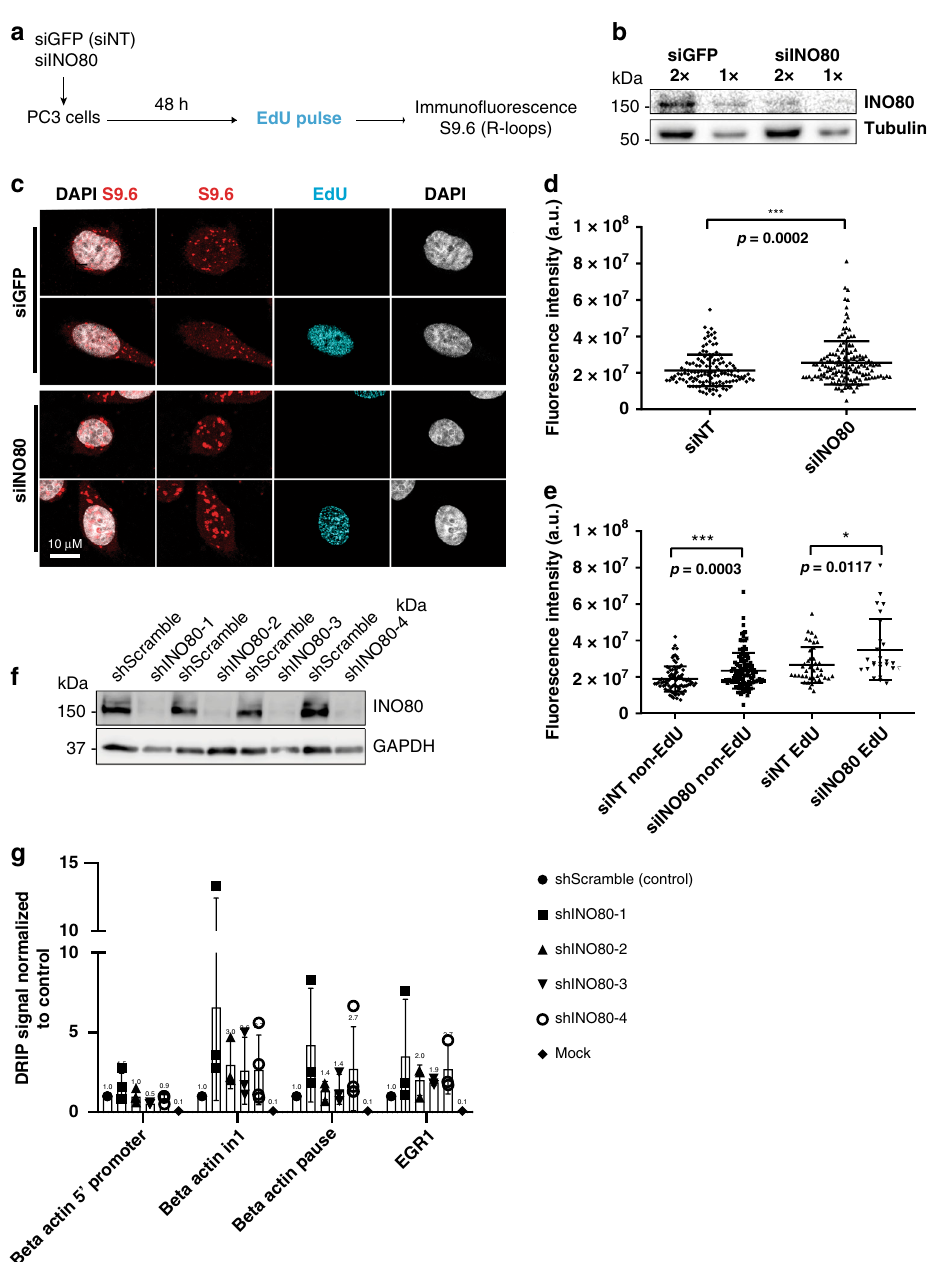
Fig. 4 R-loops accumulate in INO80-depleted cells. a Schematic representation of the experimental setup used. PC3 cells were co-transfected with esiRNAs against GFP (siNT) or INO80 (siINO80). Cells were pulsed with EdU for 15 ′ and immuno fl uorescence was carried out using the S9.6 antibody against R-loops. b Representative immunoblot of total extracts from PC3 cells transfected with esiRNAs against GFP (siGFP) or INO80 (siINO80) with an antibody against INO80 3 days after transfection. Similar results were obtained in fi ve independent experiments. c Representative confocal deconvolved images EdU positive and EdU negative cells immunostained with S9.6 n = 3 biological replicates were quanti fi ed. Scale bar is 10 μ M. d Total nuclear fl uorescence intensity of R-loops in 3D volume, in control and INO80-depleted cells. DAPI was used as a mask to measure total fl uorescence intensity of R- loops in 3D nuclear volume. Number of cells analyzed in each condition: siNT: n = 133 cells; siINO80: n = 151 cells. Data are from three independent experiments. p -value = 0.0002, (two-tailed unpaired Student ’ s t -test). e Total nuclear fl uorescence intensity of R-loops in 3D volume, in control (siNT) and INO80-depleted (siINO80) cells outside (non-EdU) and inside (EdU) S-phase. DAPI was used as in d . Number of cells analyzed in each condition: siNT (non-EdU): n = 91; siINO80(non-EdU): n = 117; siNT(EdU): n = 42; siINO80(EdU): n = 26. Data are from three independent experiments. *** p -values = 0.0003 * p -value = 0.0117, (two-tailed unpaired Student ’ s t -test). f Representative immunoblot of PC3 cells transduced with control shRNA (ShScramble) RNA and four different shRNAs targeting INO80 (shINO80-1-4) following experimental setup shown in Supplementary Fig. 4b. Similar results were obtained in 4 independent experiments. g DRIP-qPCR was performed on the indicated shRNA-treated samples using the S9.6 antibody. Values for each region tested were normalized over shControl after correction for input DNA levels. Mock IP was conducted in shControl and shINO80 samples in the absence of S9.6 antibody. Data from three independent biological replicates are presented as mean values ± SD. Source data are provided as a Source data fi